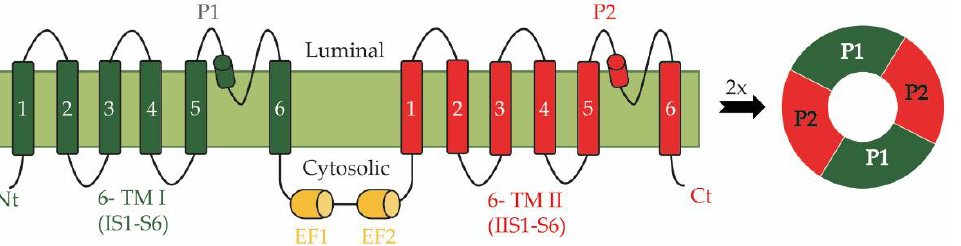
Figure 1. Topology of a plant Two-Pore Cation Channel 1 (TPC1). A TPC1-subunit is built of two concatenated copies of a structural 6-TM motif, each with six transmembrane domains (1–6). The cytosolic linker between them contains two EF-hands, which sense the cytosolic Ca 2+ concentration. Two subunits assemble into a functional channel and form a central permeation pathway.